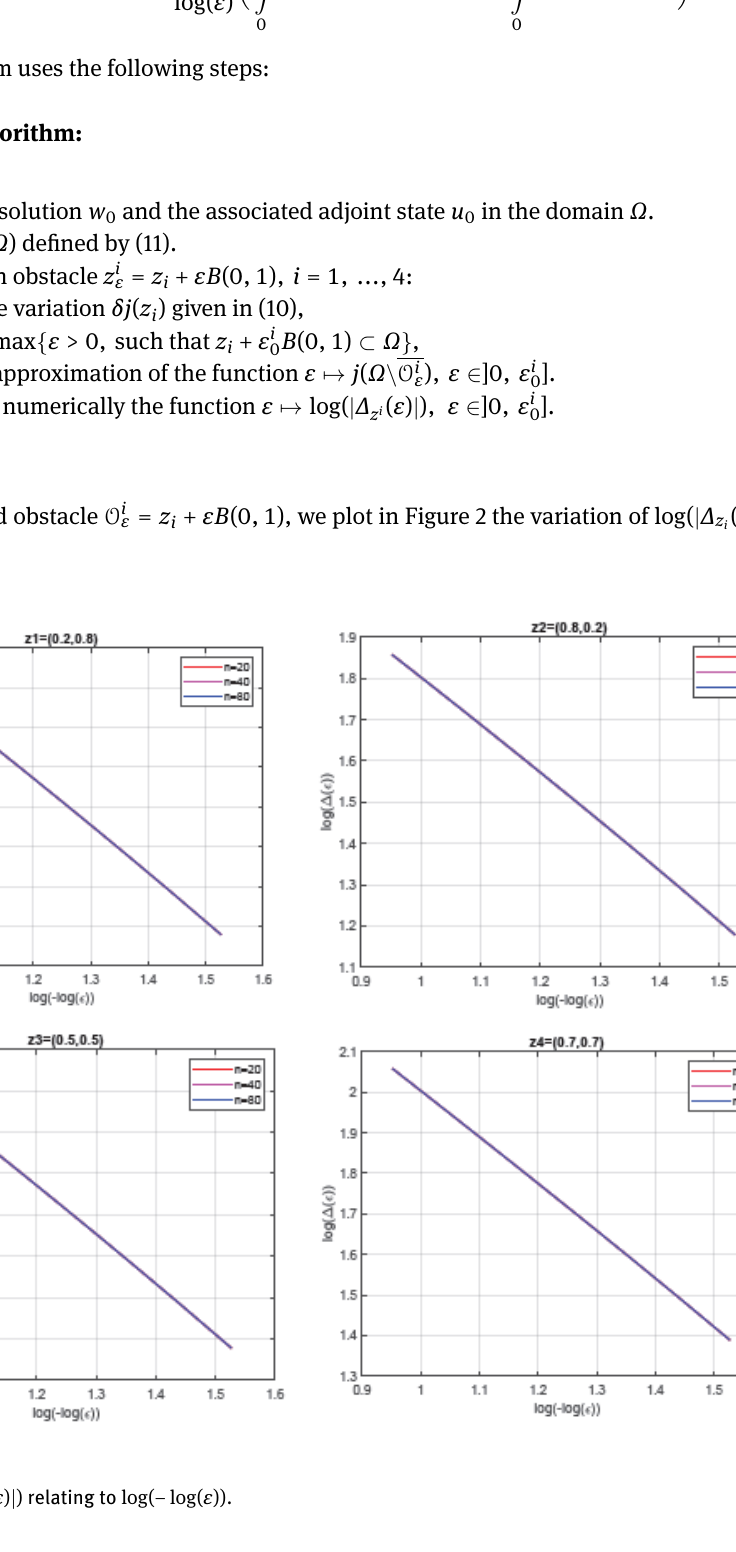
Fig. 2: Variation of log( | ∆ z